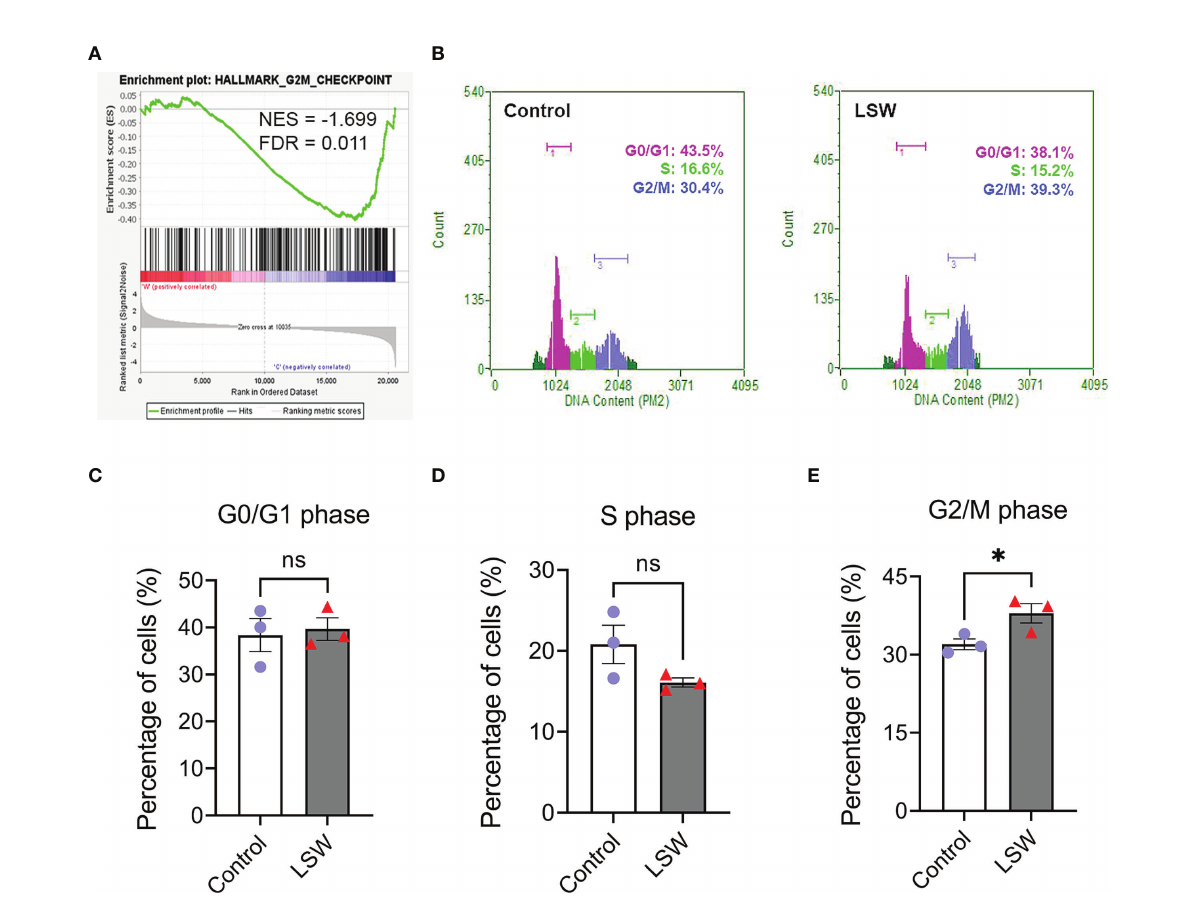
FIGURE 4 Effects of bioactive extracts from Limonium Sinense on cell cycle. (A) Gene Set Enrichment Analysis (GSEA) plot showing an enrichment of Hallmark_G2/M_checkpoint in MDA-MB-468 cells treated with Limonium Sinense water extracts (LSW, 500 m g/ml). Normalized enrichment score (NES) and false discovery rate (FDR) are indicated. (B) Representative fl ow cytometry histograms of the percentage of cells in G1, S and G2/M phases of the cell cycle from MDA-MB-468 treated with or without LSW (500 m g/ml) for 24 hours. (C – E) Graphs showing the percentage of cells in G0/G1 (C) , S (D) , or G2/M (E) phases. Data are mean±SEM. n = 3 samples per group. ns, not signi fi cant; * P < 0.05 by the Student ’ s t